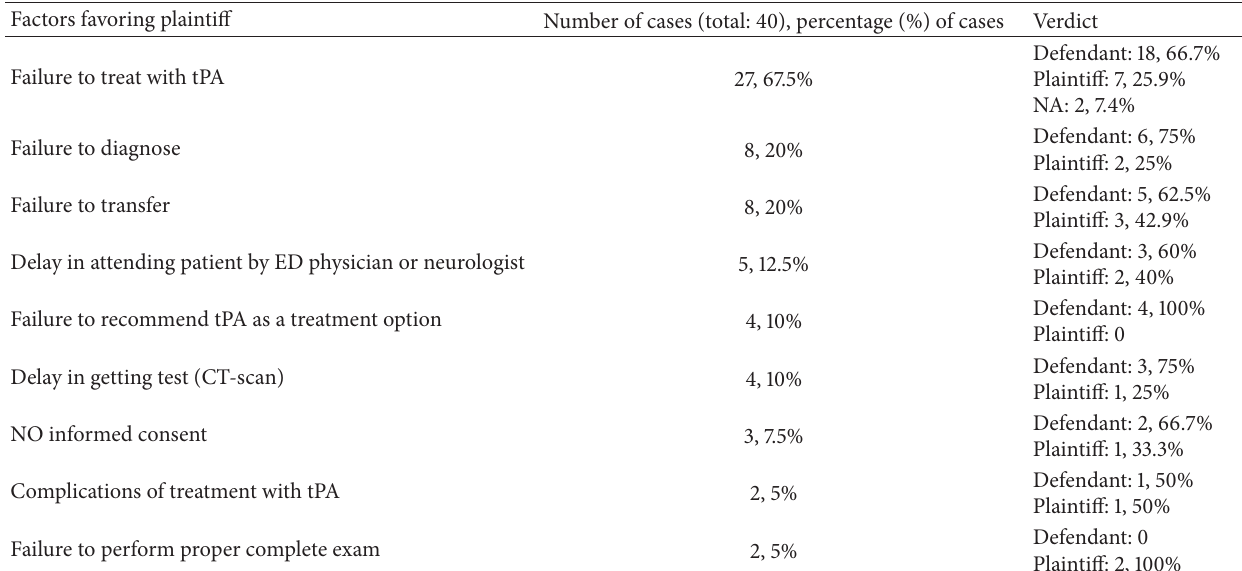
Table 4: Frequency of factors favoring